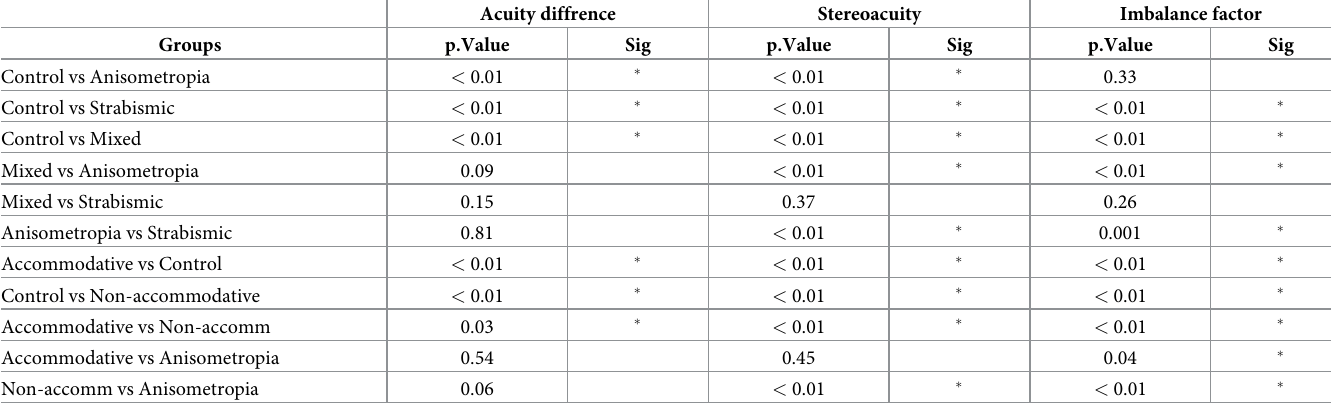
Table 4. Means pair comparison between group pairs for each triplet variable. P-value and significance (p-value < 0.05) for each triplet variable (visual acuity differ- ence, stereoacuity and imbalance factor) per each group classification pair. Both group classifications are considered, amblyogenic factor (control, refractive, strabismus and mixed) and refractive response (accommodative and non-accommodative).